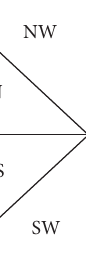
Figure 4: The 8-direction cone model.